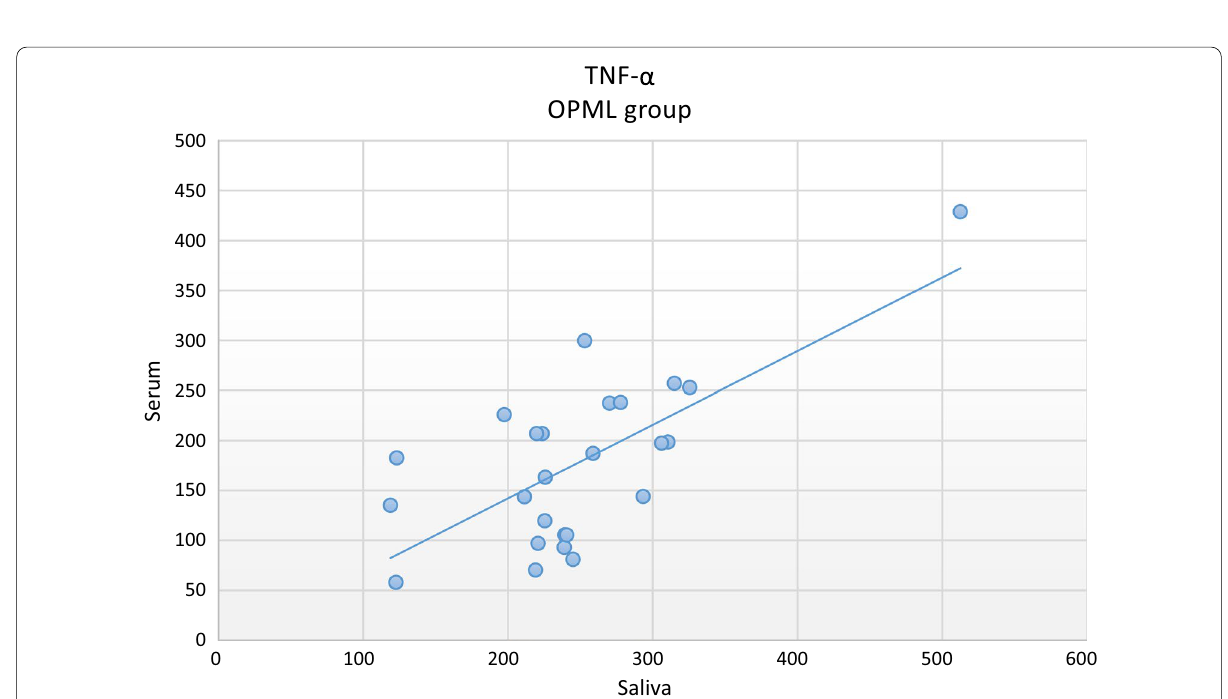
Fig. 7 Correlation between serum and saliva TNF-α expression in OPML group as determined by Pearson’s correlation coefficient